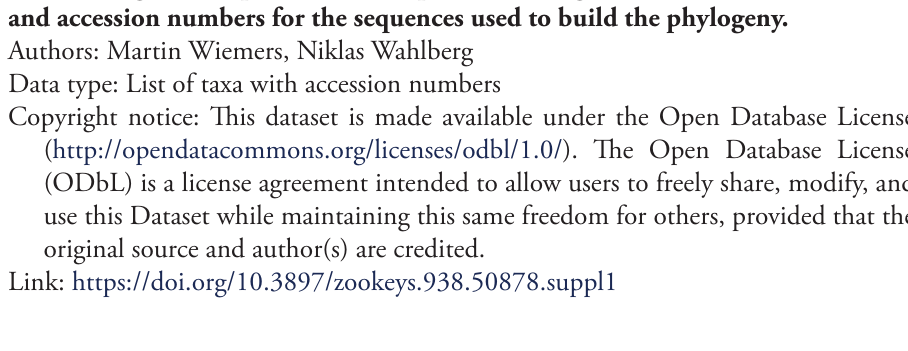
Table listing of European butterfly species with higher taxonomy, voucher codes and accession numbers for the sequences used to build the phylogeny.